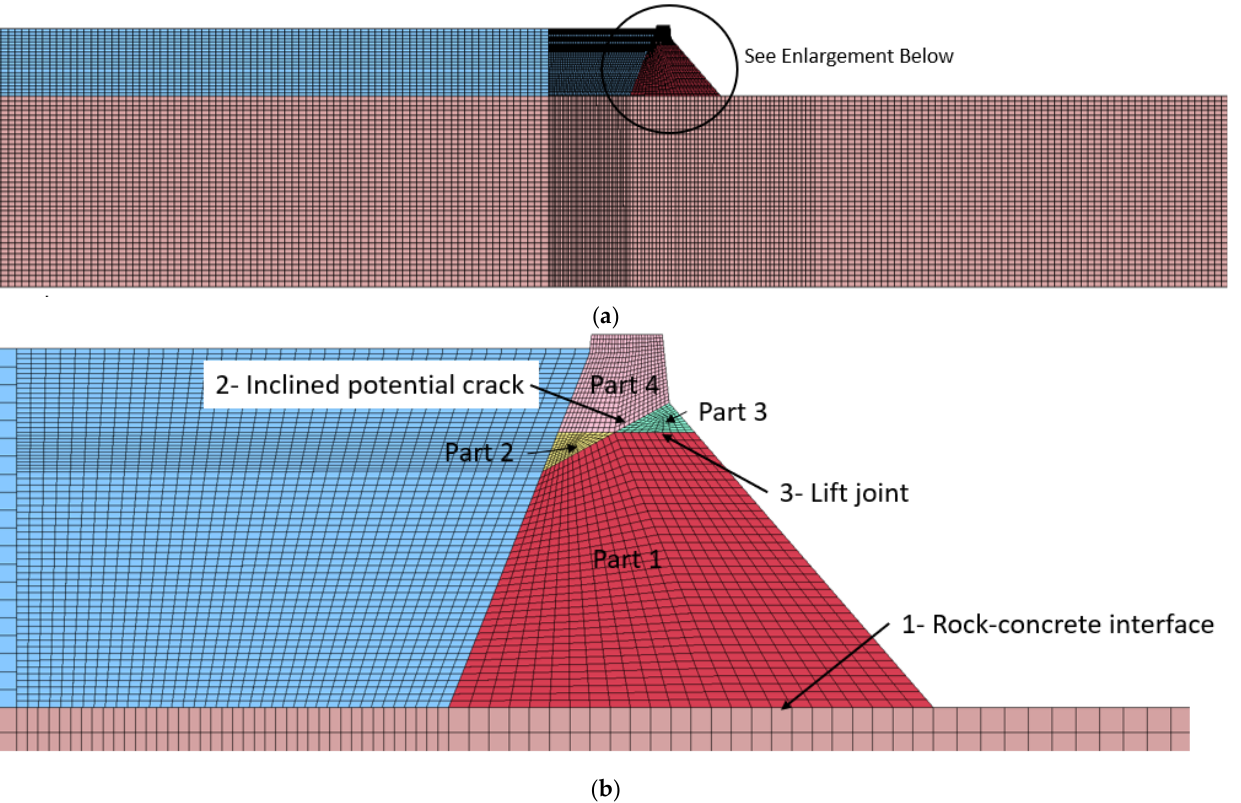
Figure 4. 2D Model through monolith 15 showing: ( a ) dam, foundation, and reservoir; ( b ) close-up of cross-section showing contact elements at rock (foundation)—concrete interface, potential inclined crack, and lift joint crack at the base of the chimney section. The brown elements represent the foundation bedrock, blue represents the reservoir and the four colors in the dam cross-section represent the different parts of the dam produced by the contact surfaces with the model (labeled 1, 2 and 3).